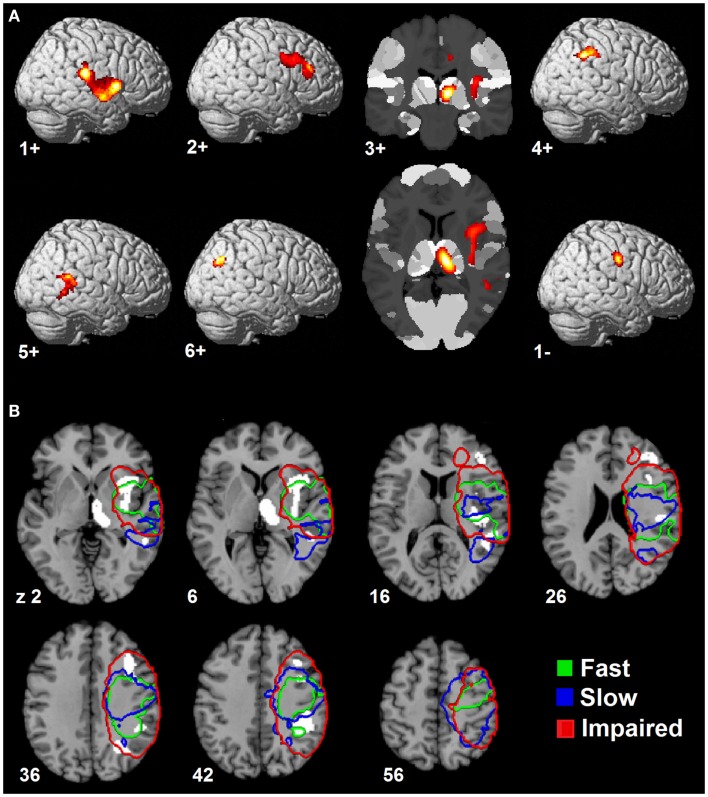
Spatial topography of longitudinal structural covariance network correlating with hand function recovery. (A) shows the six largest clusters of supra-threshold voxels for the second principal component (PC2TBM) projected onto a standard three dimensional brain and onto a cytoarchitectonic atlas (cluster 3+) in MNI space. Clusters are labeled according to their (positive or negative) correlation with gray matter volume expansion in the medio-dorsal thalamus. The threshold for positive clusters corresponds to the first percentile of voxel values (absolute value 0.0064), the threshold for the negative cluster to the ninety-ninth percentile (absolute value 0.0095). (B) shows the spatial relationship between the covariance network clusters and lesion maps of patient subgroups. Color-coded contours define areas with ≥20% lesion probability in each subgroup. Size, localization, cytoarchitectonic assignment, and functional correlates of the individual clusters are summarized in Table 3.